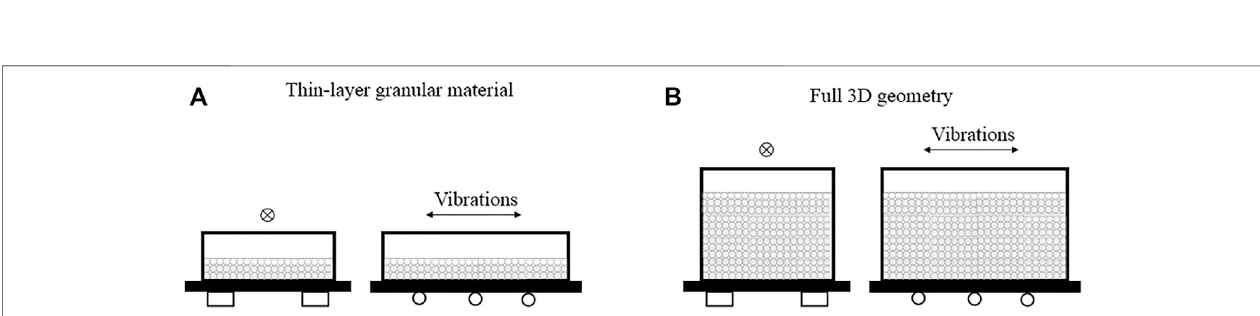
FIGURE 3 | General setup for the shaking bed test of granular material: (A) thin-layer; (B) full 3D geometry.